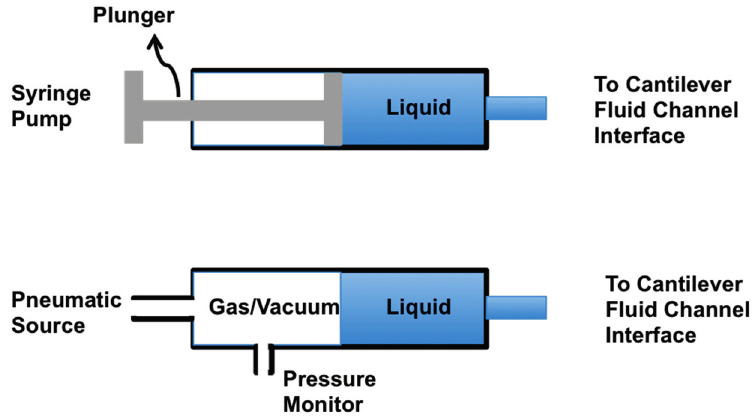
Figure 9. Syringe-based pumping and pressure-based